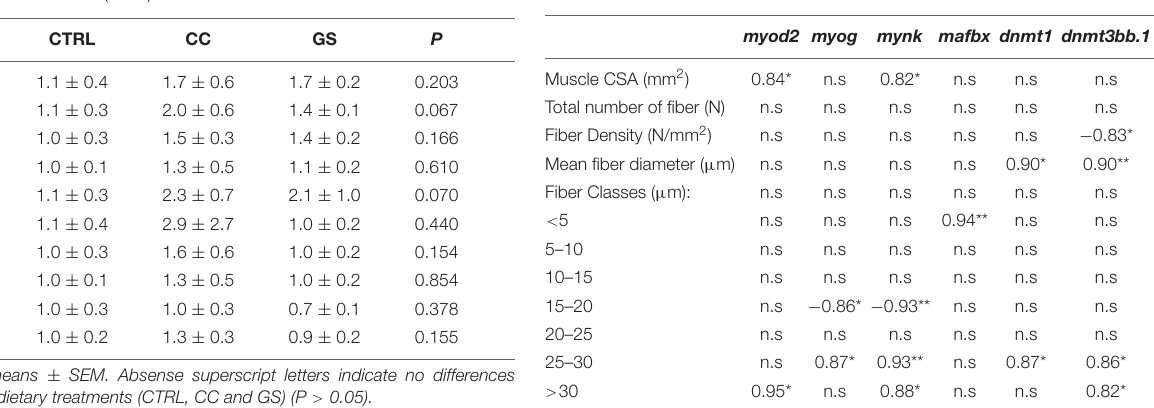
TABLE 5 | Correlations (Pearson’s coefficient, n = 3) between muscle cellularity, somatic growth or gene expression data in Senegalese sole post-postlarvae, at